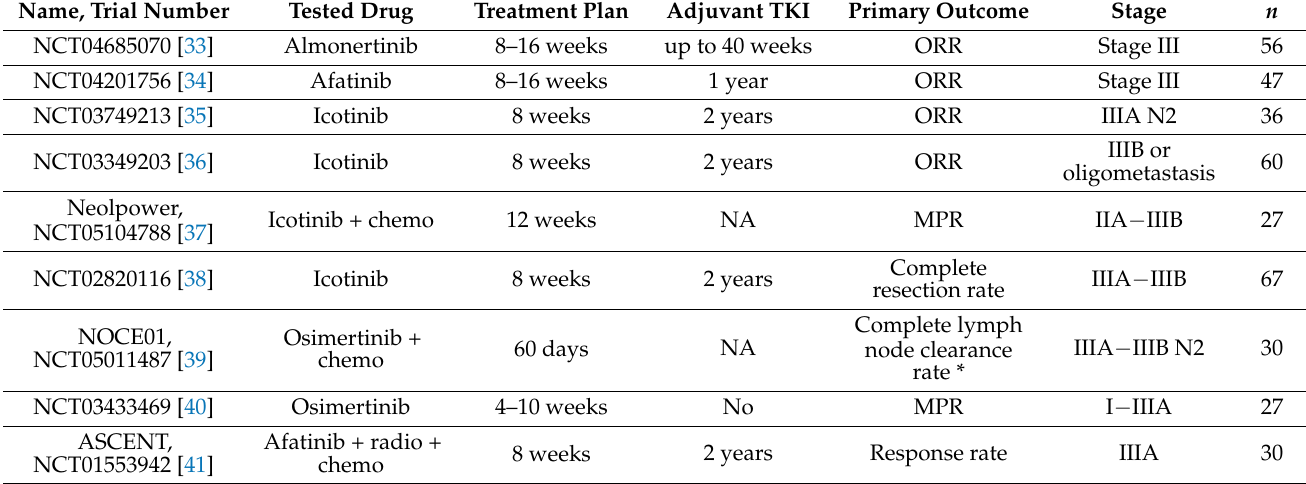
Table 2. Ongoing phase II trials considering neoadjuvant therapy. All these data are available on https://www.clinicaltrials.gov/ (accessed on 30 March